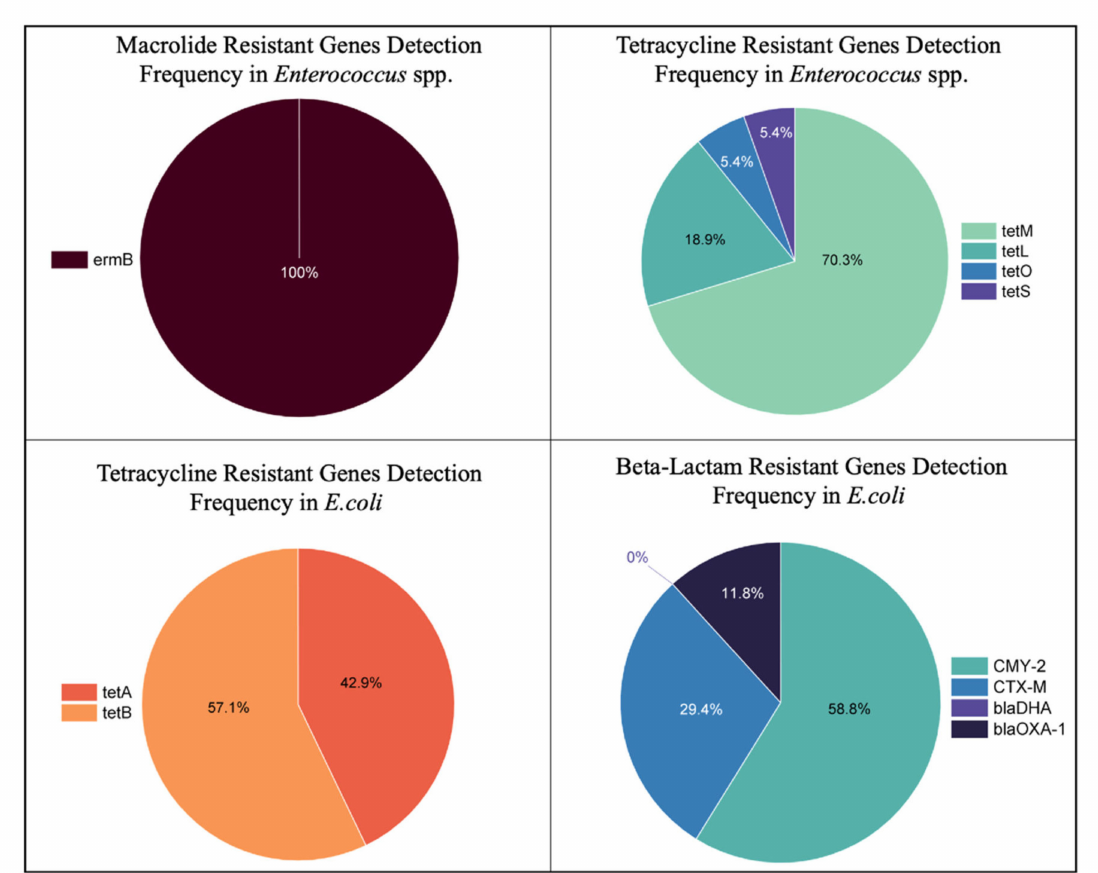
Figure 4. Detection frequency of ARGs associated with resistance phenotypes for all E. coli and Enterococcus spp. isolates in the Tampa Bay metropolitan Area, FL urban karst groundwater